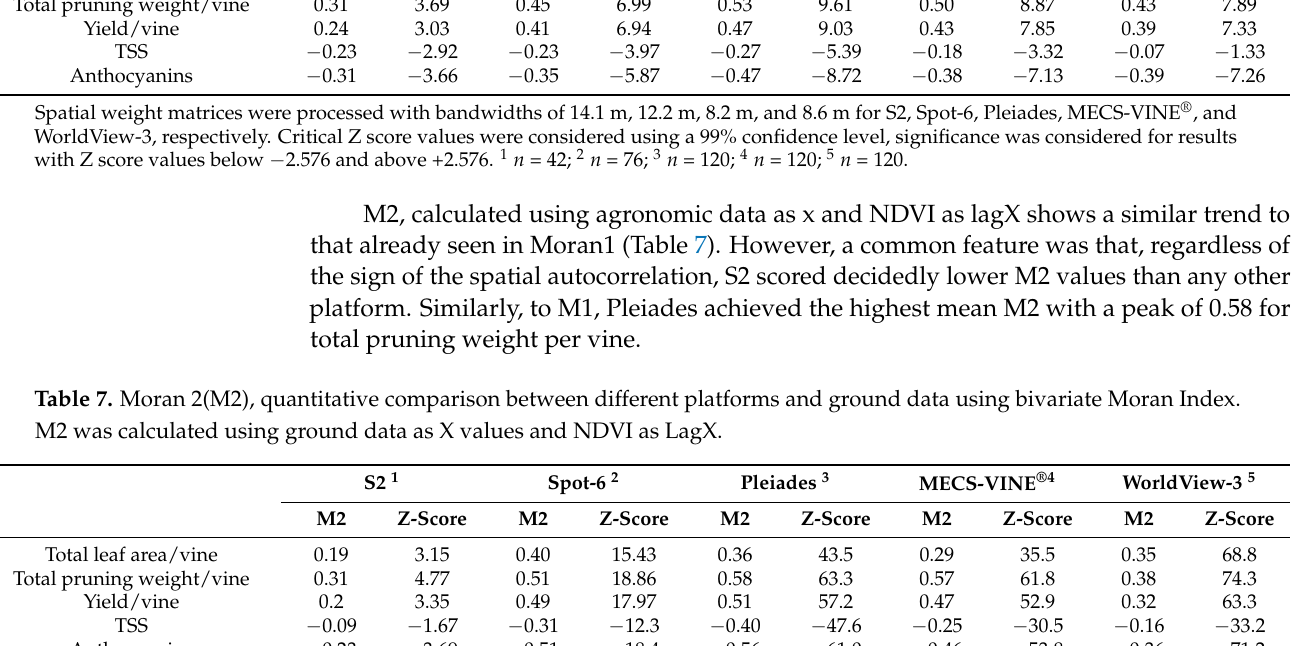
Table 6. Moran 1 (M1), quantitative comparison between different platforms and ground data using bivariate Moran Index. M1 NDVI values as X and ground data al Lag-X. S2 1 Total leaf area/vine